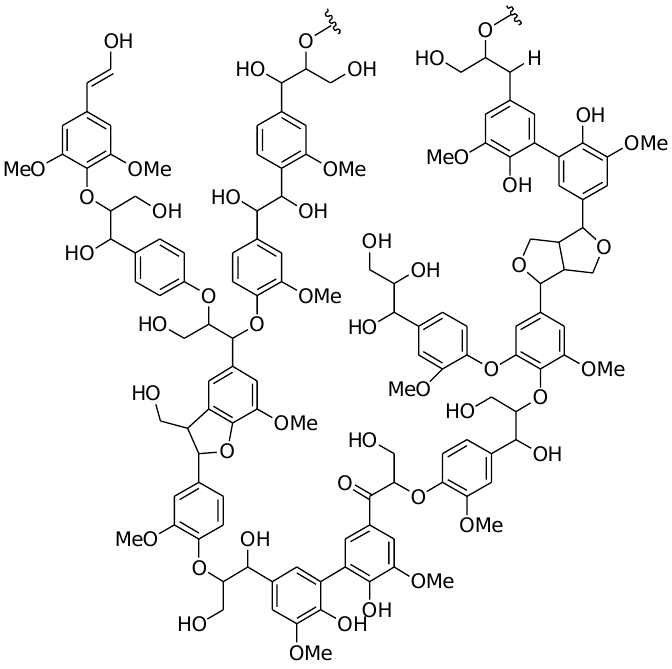
Figure 1. A hypothetical structure of lignin.